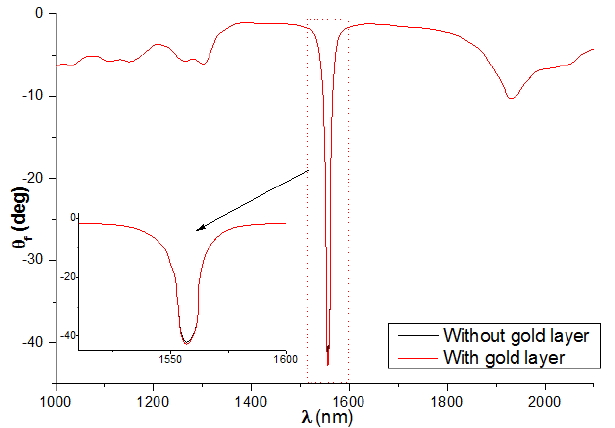
FIGURE 4. The Faraday rotation